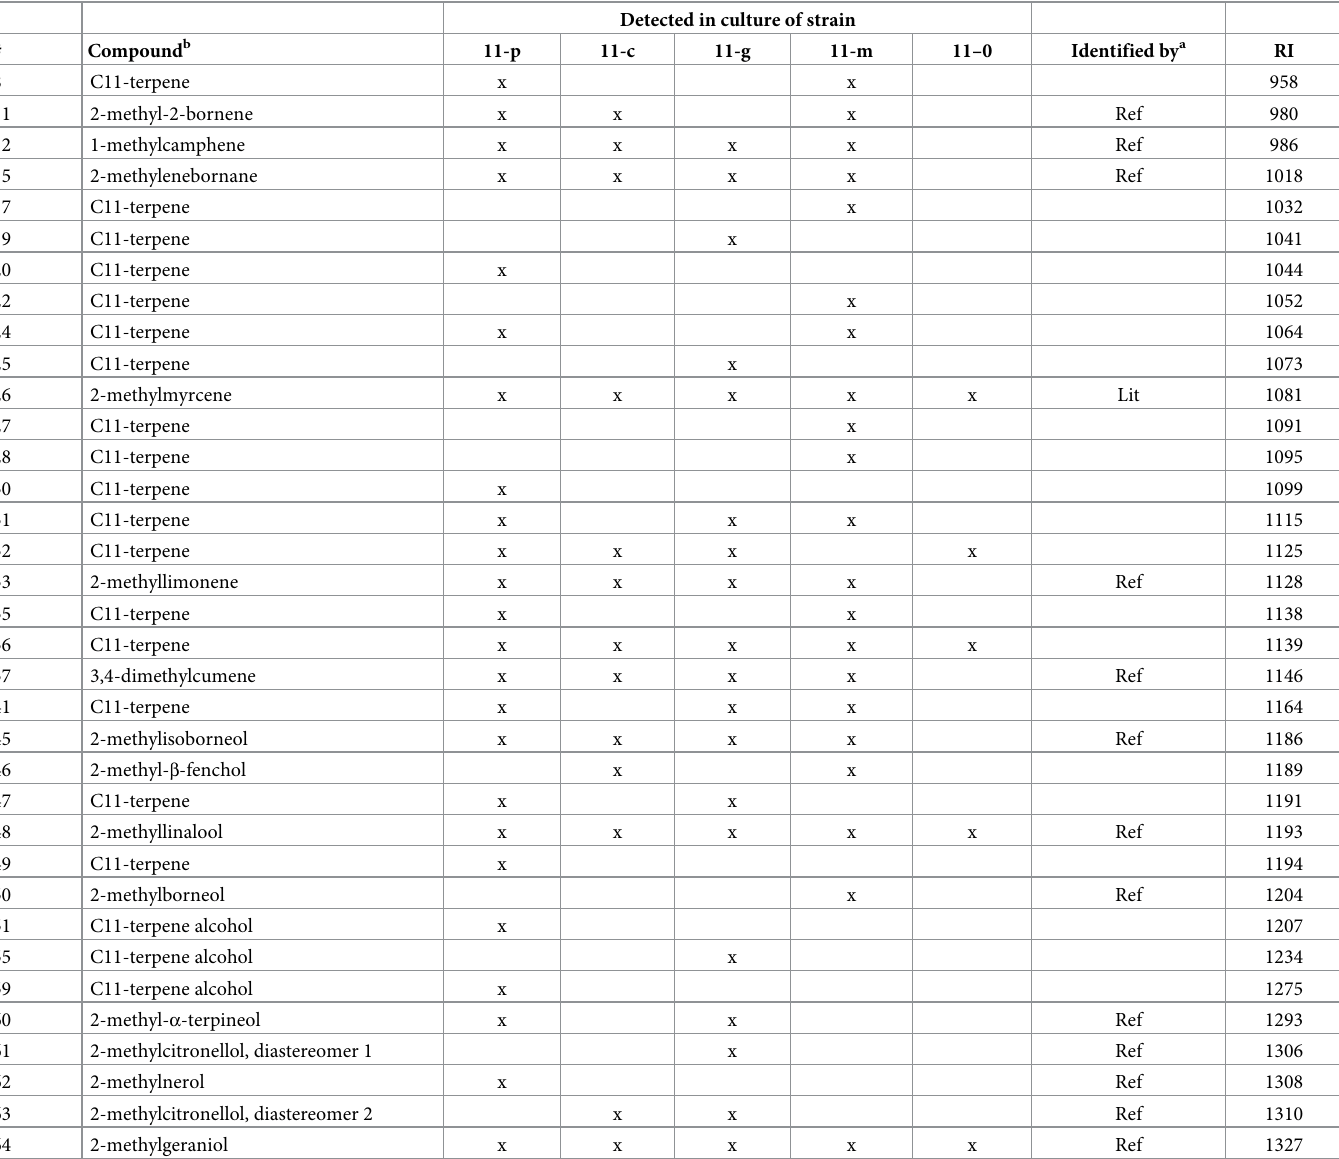
Table 3. C11-compounds detected in the headspace of four C11-terpene production strains (11-p, 11-m, 11-g, 11-c) and one control strain without TS (11–0). Detected in culture of